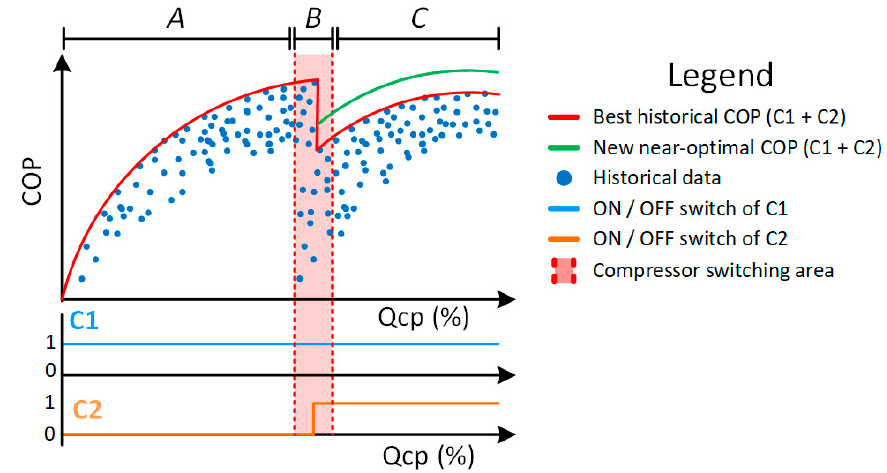
Figure 3. The theoretical three stages curve of the partial load ratio (PLR) problem of two screw compressors C1 and C2 working in parallel to supply the cooling demand of a refrigeration system.